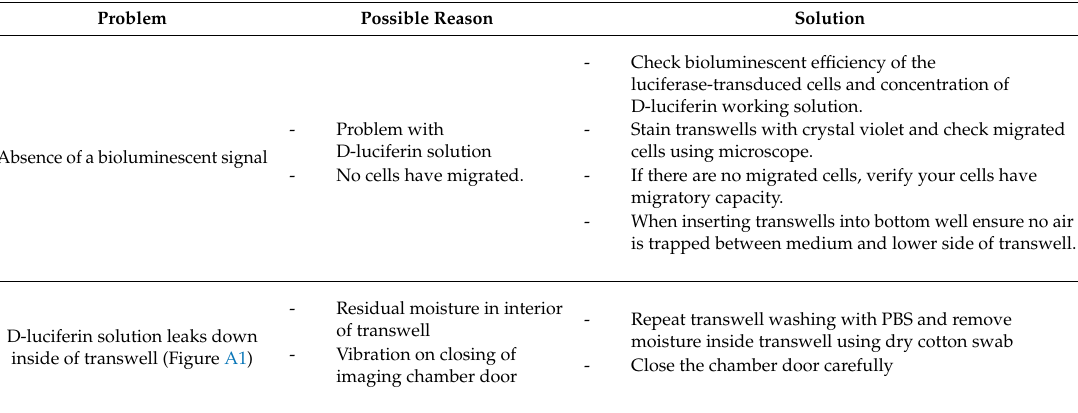
Table A2. Troubleshooting guide for bioluminescence migration